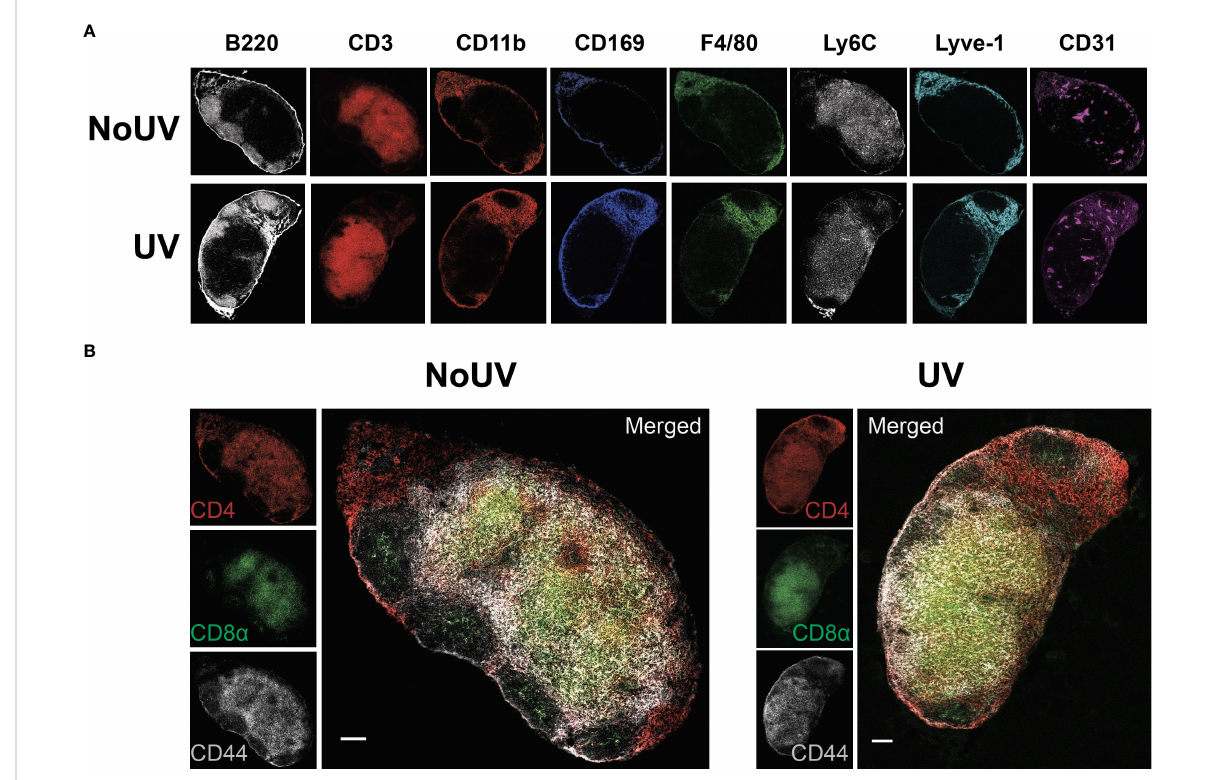
FIGURE 1 UV exposure does not alter skin-draining lymph node architecture. Skin-draining (inguinal) lymph nodes were collected from mice exposed (or not) to 8 J/cm 2 UV 24 h after exposure. Lymph node sections were stained and analyzed by imaging mass cytometry. (A) Representative images of immune and structural markers. (B) Representative images of CD4 + , CD8 + , and CD44 + T cells. Scale bars represent 100